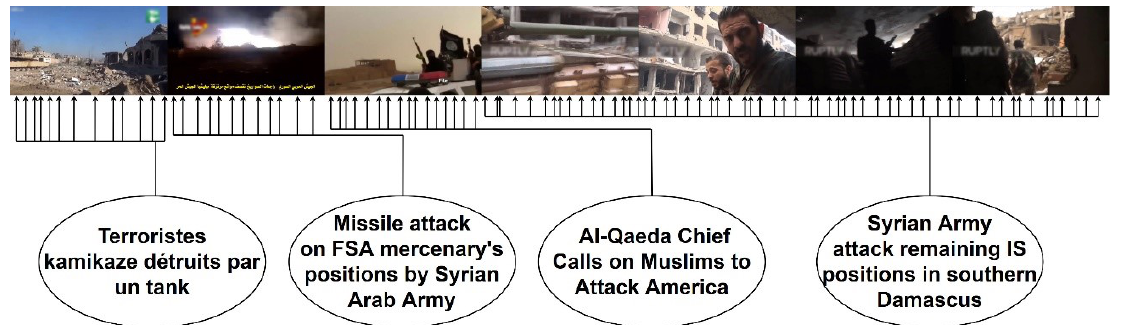
Figure 4. Schema of the process used to convert videos into hashes.